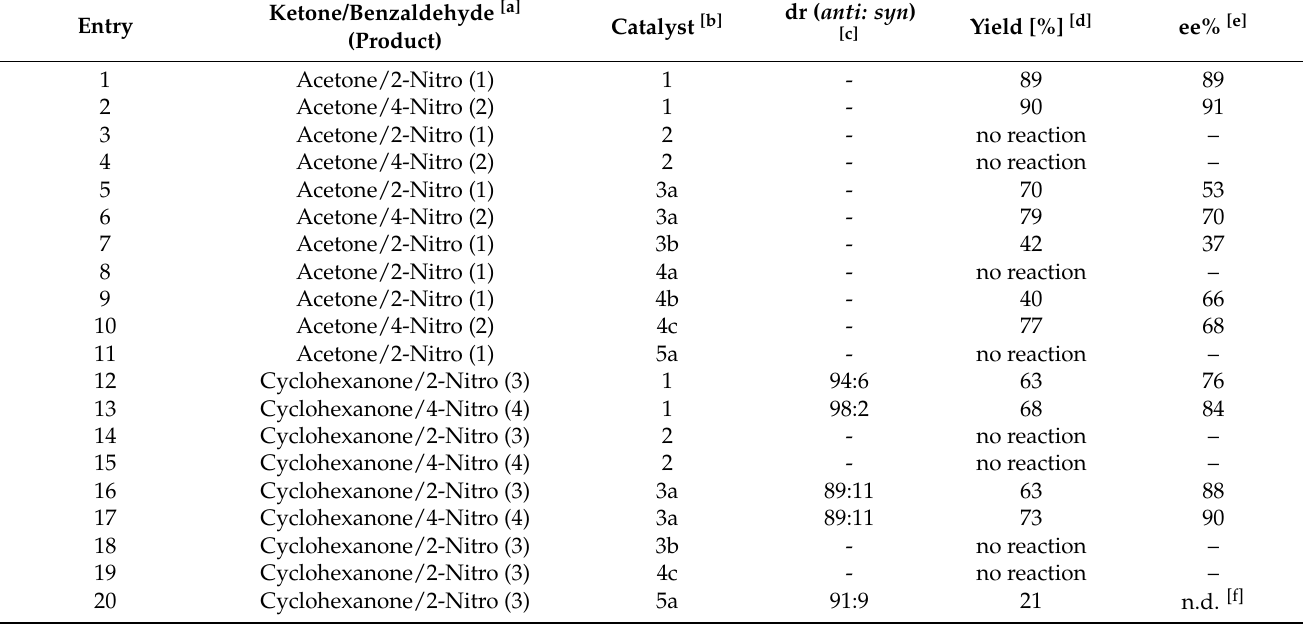
Table 1. Asymmetric aldol reaction using acetone or cyclohexanone with 2- or 4-nitrobenzaldehyde as model compounds and chiral RTILs based on S-protected-l-Cysteine as